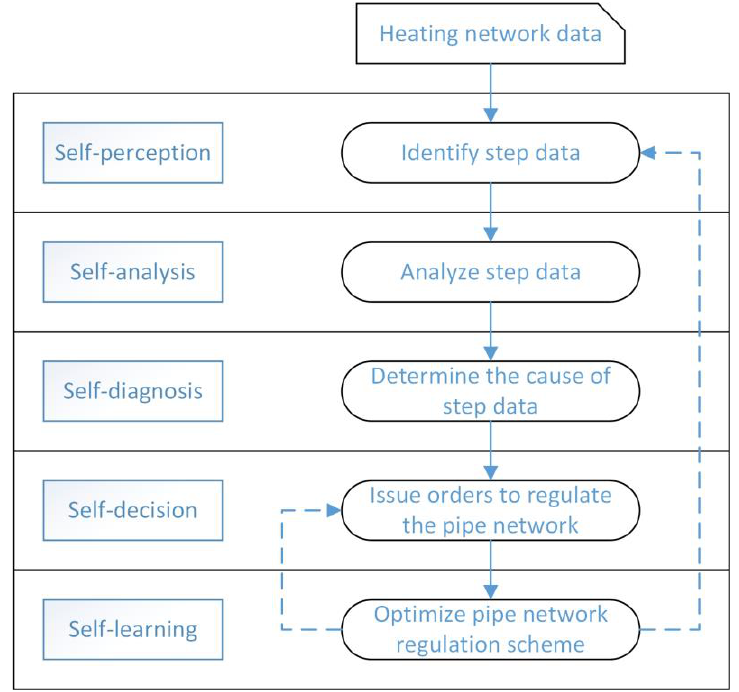
Figure 11. Step data route for smart heating.